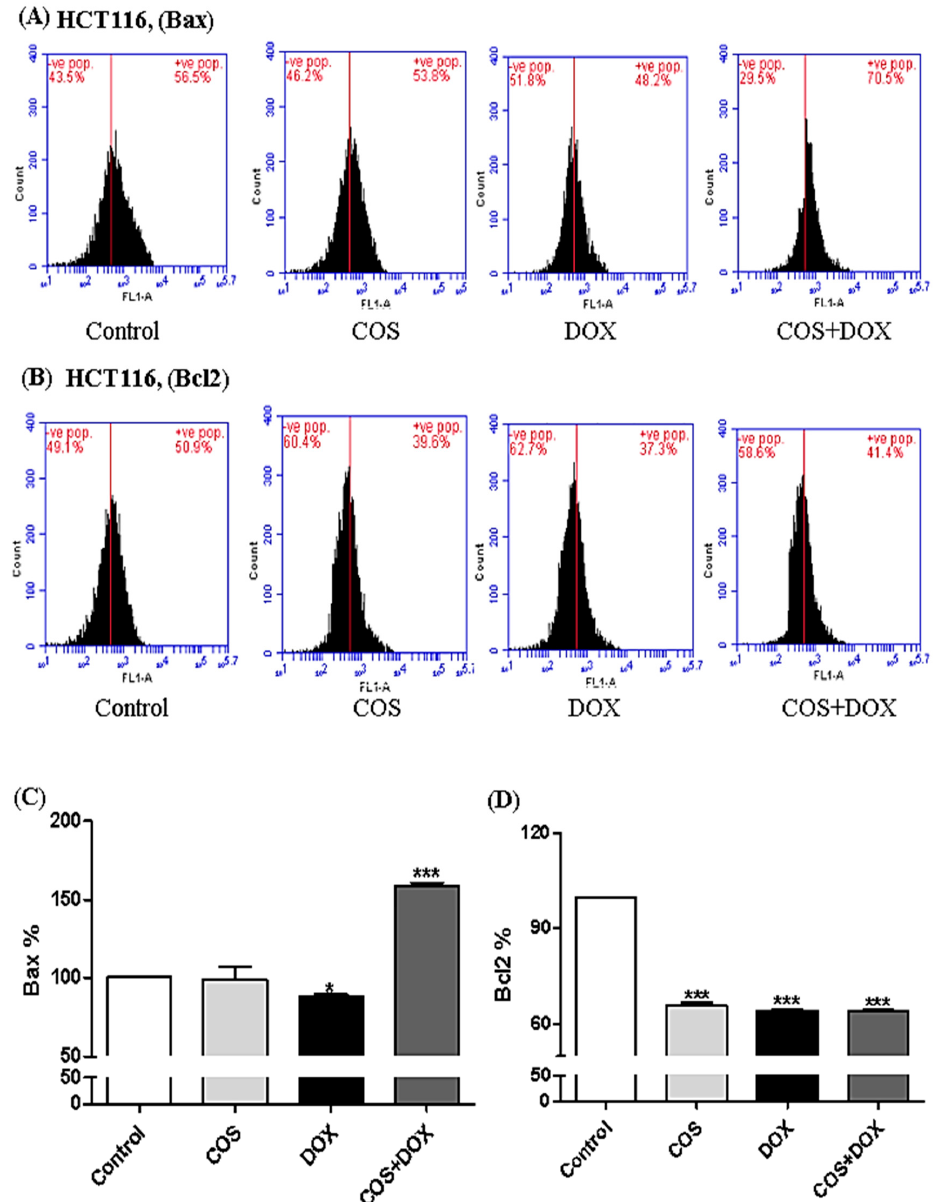
Figure 3. Bcl2-associated X protein (Bax) and B-cell lymphoma 2 (Bcl2) protein expressions in HCT116. ( A ) Bax flow cytometer histogram. ( B ) Bcl2 flow cytometer histogram. ( C ) Bax percentages in costunolide (COS), doxorubicin (DOX), and costunolide + doxorubicin (COS+DOX) relative to the control group. ( D ) Bcl2 percentages in COS, DOX, and COS+DOX relative to the control group. Values are presented as mean ± SD. * p < 0.05 and *** p < 0.001.